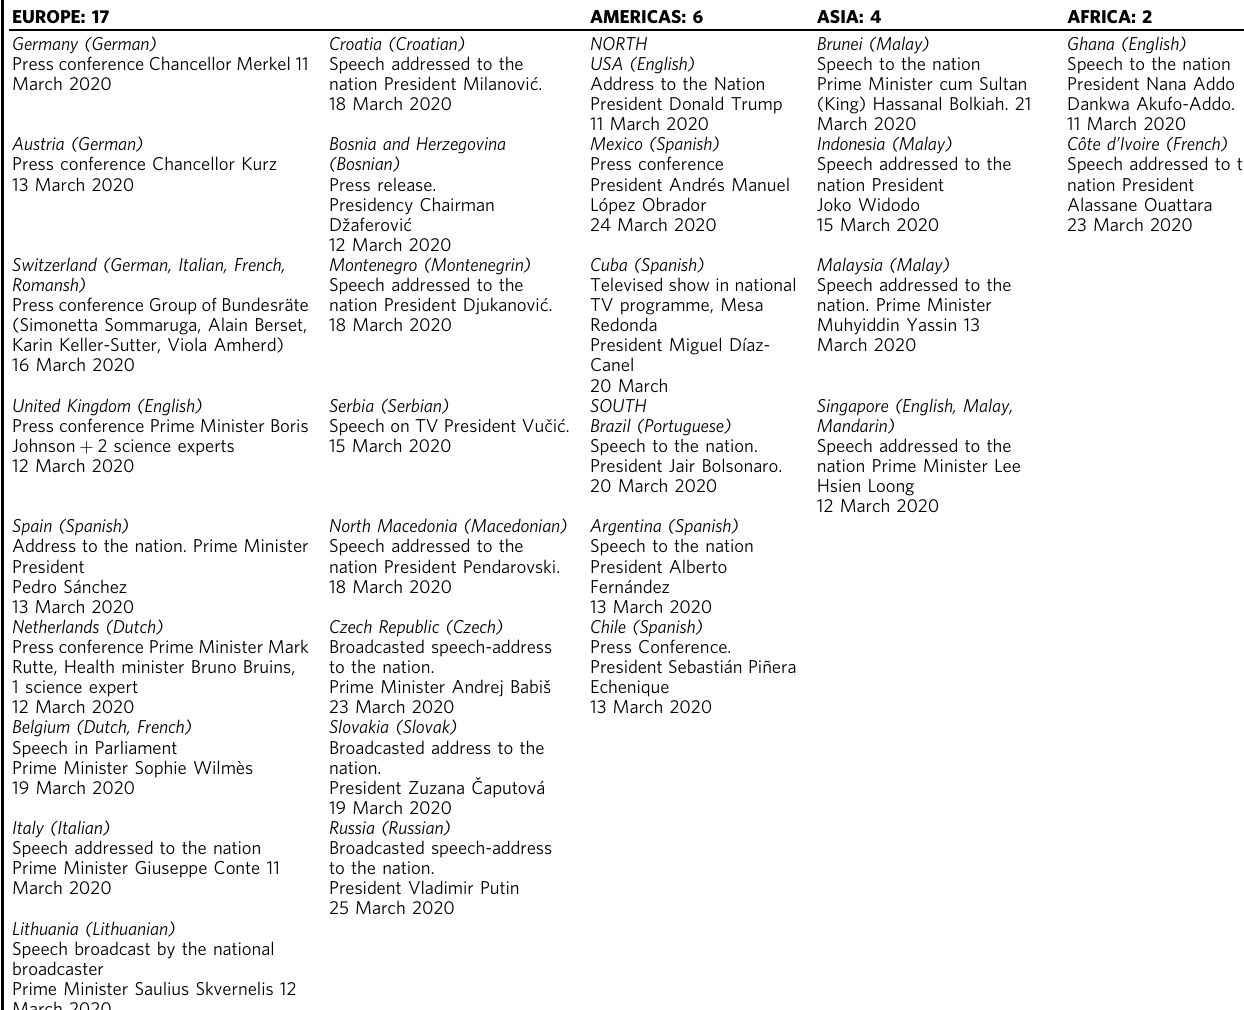
The fi rst topic was the containment of the danger originating from the coronavirus. The virus has arrived in Europe. It is here. We need to understand